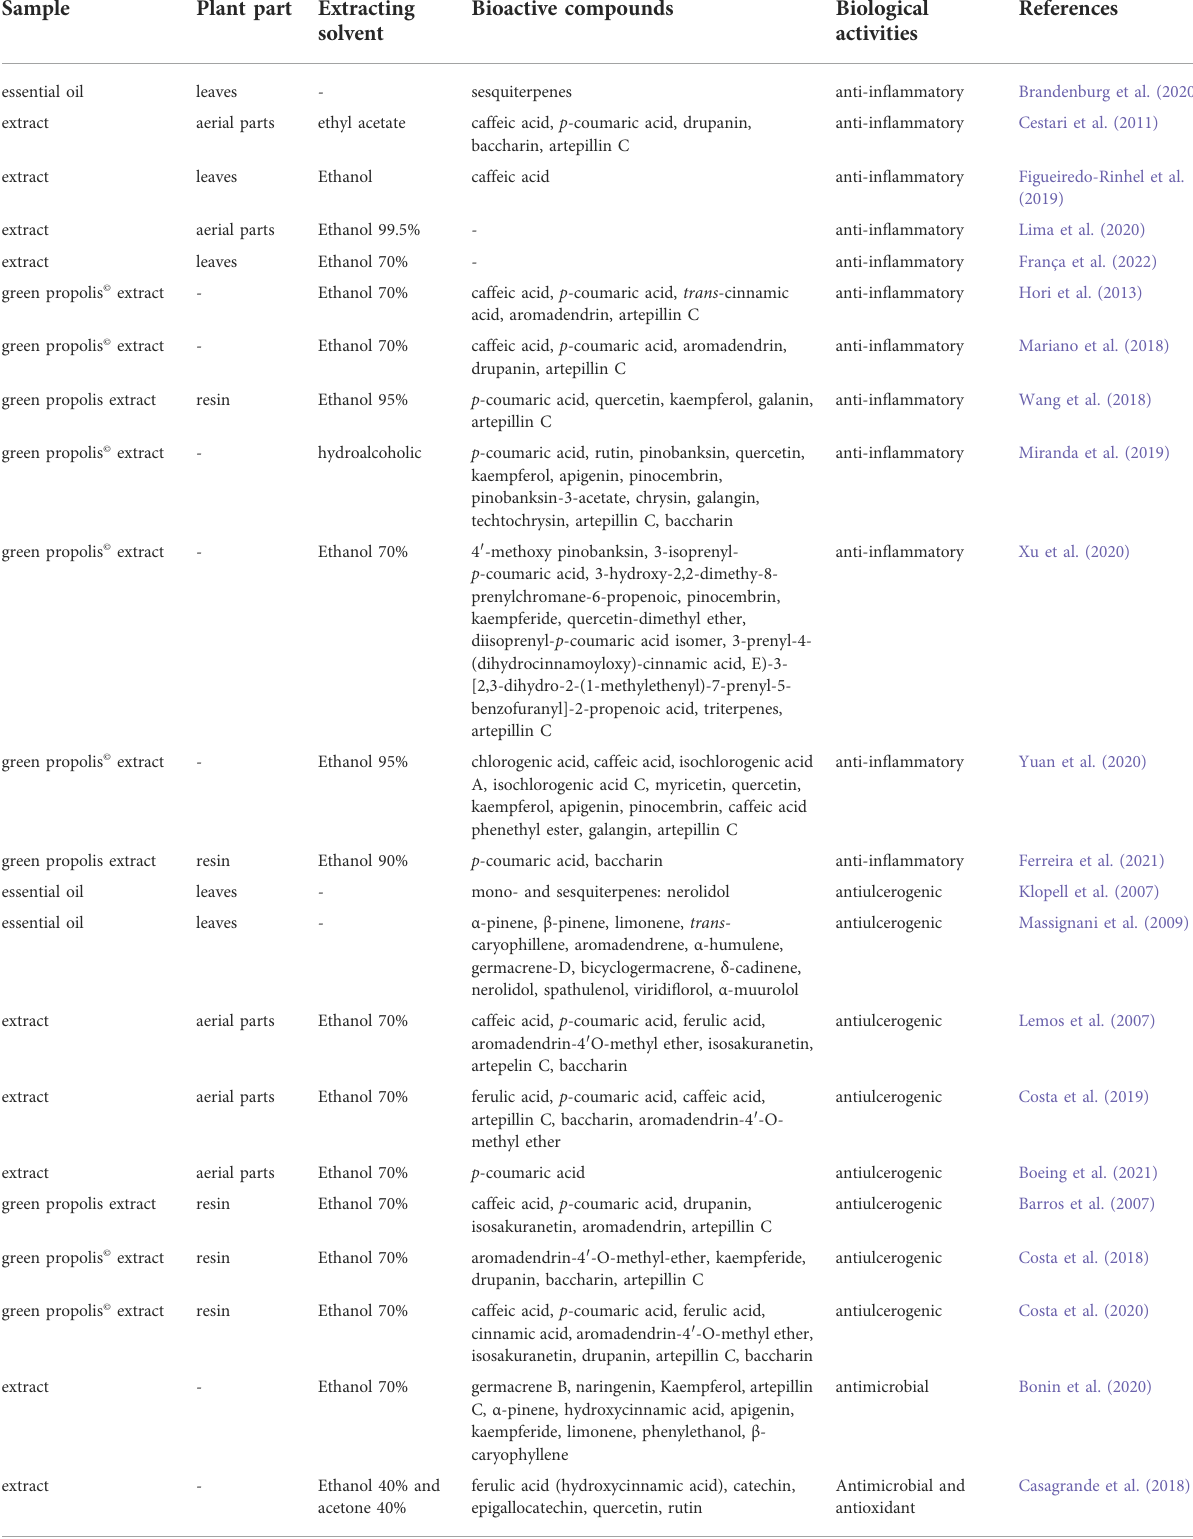
TABLE 3 Summary of biological activities and bioactive compounds reported in various studies, including plant parts and extracting